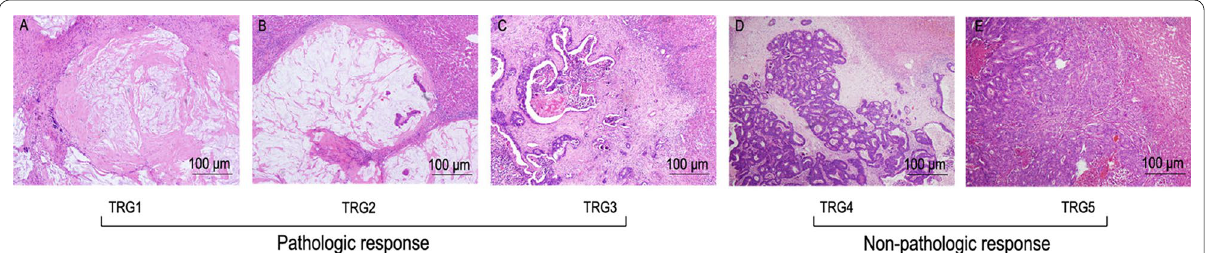
Fig. 1 Pathologic response according to the tumor regression grade (TRG) scoring standard. A TRG1, absence of residual cancer cells and an abundance of fibrosis. B TRG2, a large amount of fibrosis and scattered rare residual cancer cells. C TRG3, more residual cancer cells, but fibrosis predominates. D TRG4, presence of abundant residual cancer cells that predominate over fibrosis; and E TRG5, almost completely cancer cells with an absence of